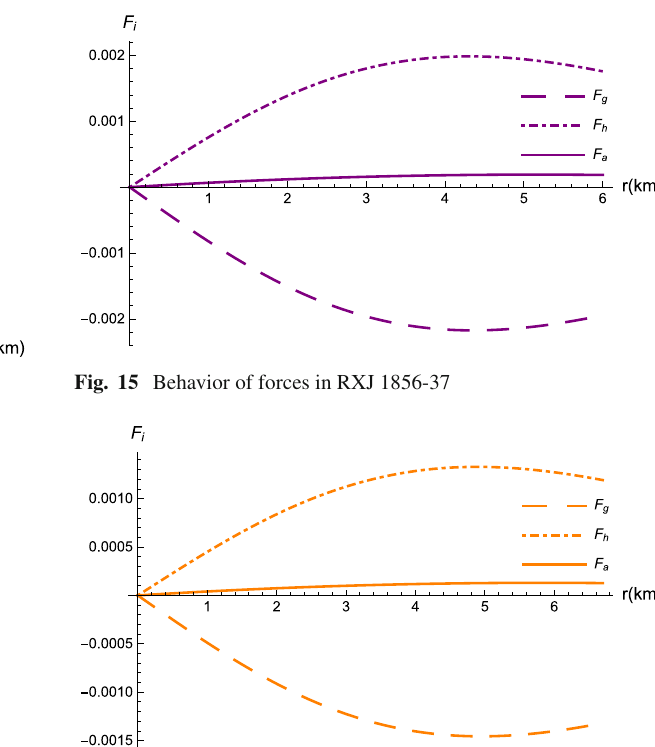
Fig. 16 Behavior of forces in Her X-1